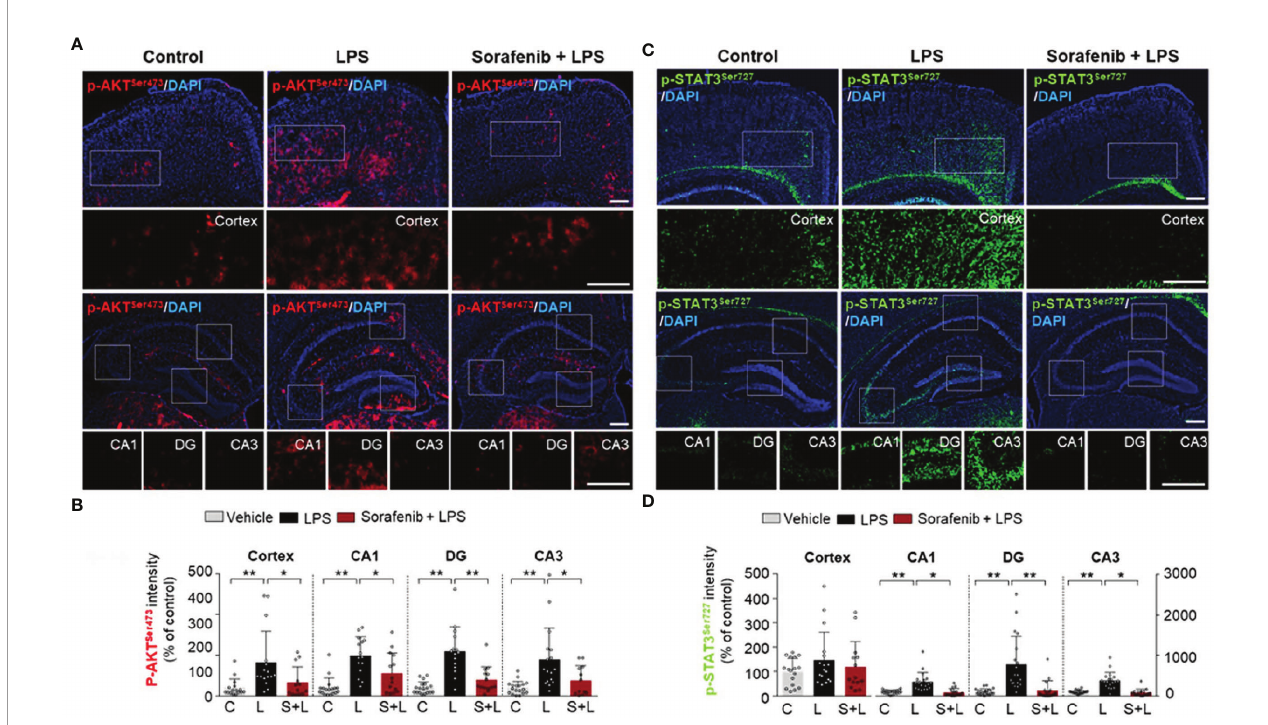
FIGURE 5 | Pretreatment of sorafenib decreases LPS-mediated AKT and STAT3 phosphorylation in wild-type mice. (A, C) Immuno fl uorescence staining with anti-p- AKT S473 and anti-p- STAT3 S727 antibody of brain slices from wild-type mice treated with sorafenib followed by LPS. (B, D) Quanti fi cation of the data in (A, C) (analyzed number of brain slices/images (n); p-AKT S473 : Vehicle, n =16; LPS, n=16; Sorafenib + LPS, n=14, p-STAT3 S727 , Vehicle, n=23; LPS, n=22; Sorafenib + LPS, n=20). *p < 0.05, **p < 0.01, Scale bar = 200 m